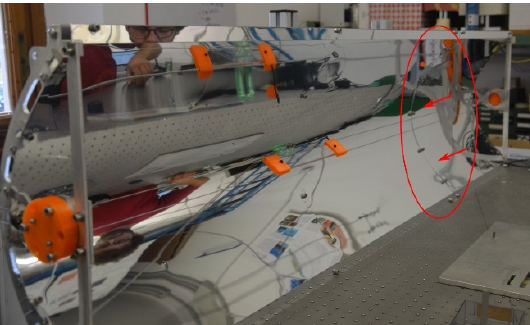
Figure 6. The m-PTC mounted on the optical table; the target is held by two steel cables. The red arrows indicate the region of conjunction between the two sections of the mirror.